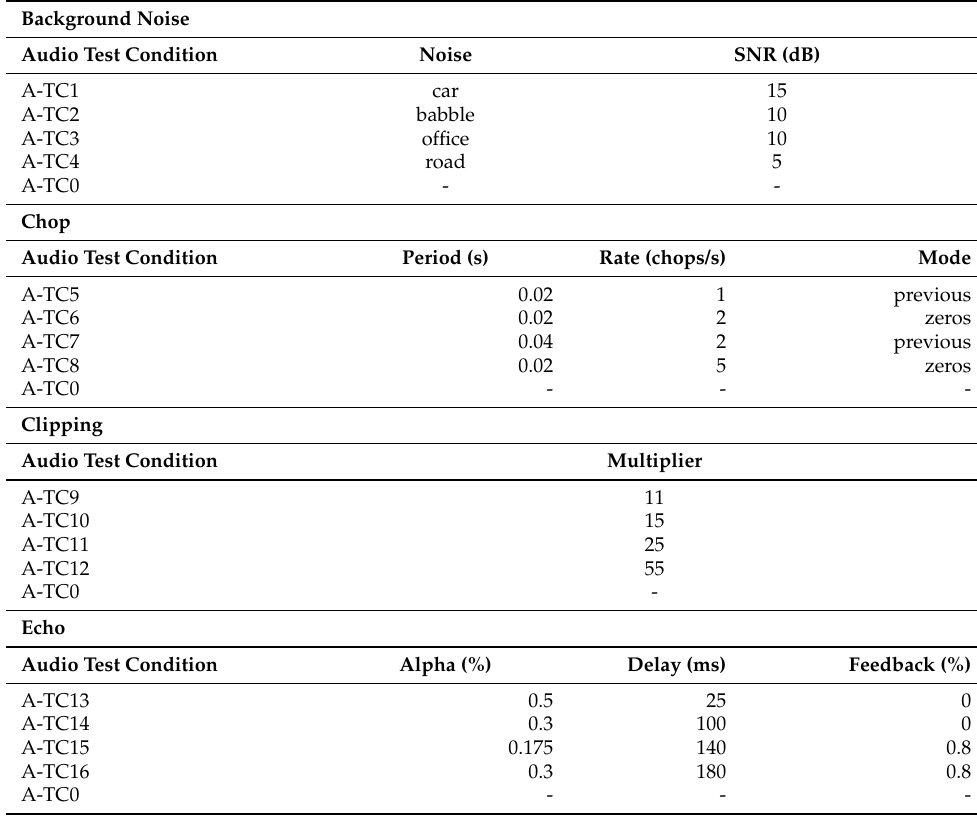
Table 11. Audio Test Condition (A-TC) corresponding parameters used in Experiment 1, 2, and